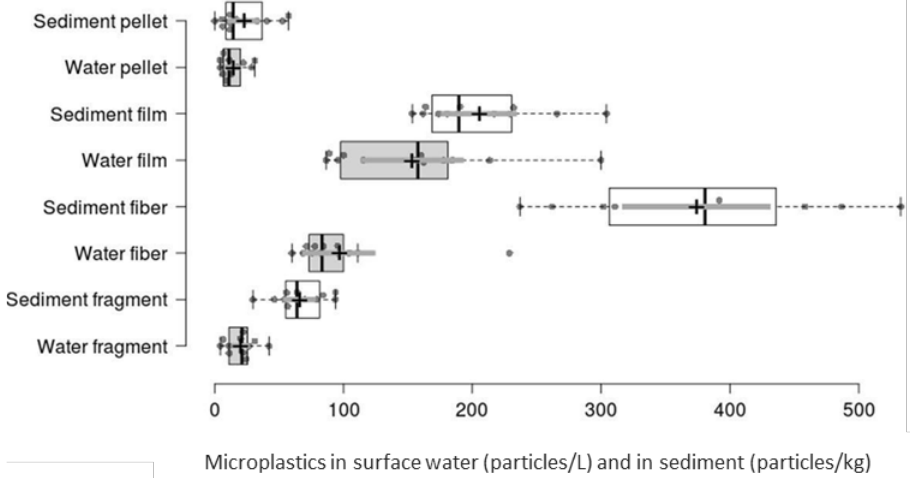
Fig. 3: Average and 95% Confidence Interval of microplastic abundance in Jakarta Bay surface water and sediment